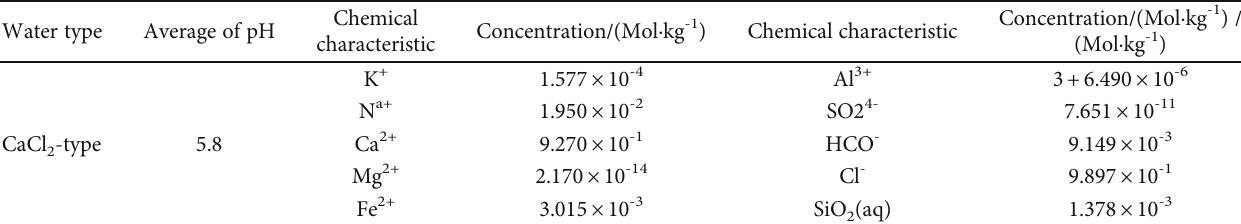
Figure 4: Spatial distribution of mineral abundance, CO concentration (aqueous phase) and formation pressure from simulations. (a) 2 Three-dimensional conceptual model of deep hydrothermal fl uid; (b) pro fi le changes of redistributed calcite abundance at di ff erent injection stages; (c) pro fi le changes of CO concentration (aqueous phase) in aqueous phase over time; (d) pro fi le changes of formation 2 pressure over time. Table 1: Initial water chemical